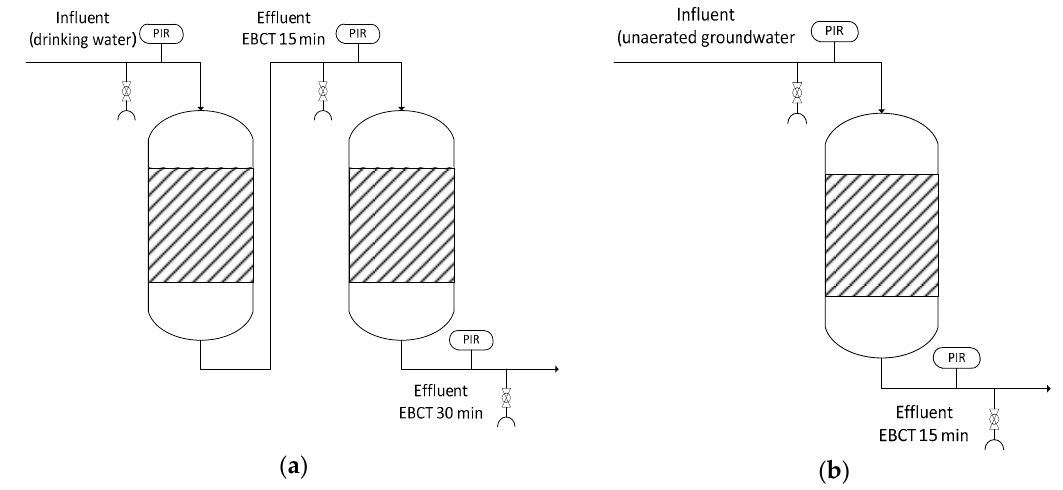
Figure 1. Scheme of the GAC pilot: ( a ) two fixed-bed adsorbers in series fed with drinking water; ( b ) single fixed-bed adsorber fed with un-aerated groundwater. Sampling and pressure measuring points (PIR) are indicated.